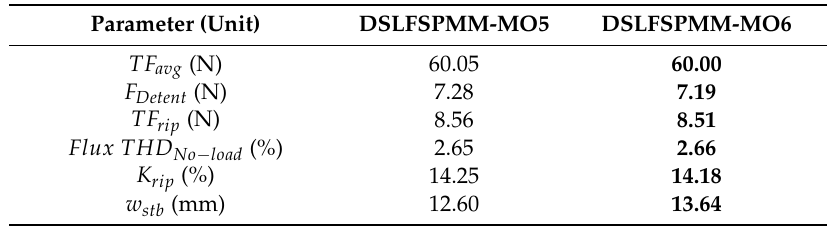
Table 12. Modified parameter and performance comparison of DSLFSPMM-MO5 with DSLFSPMM-MO6.